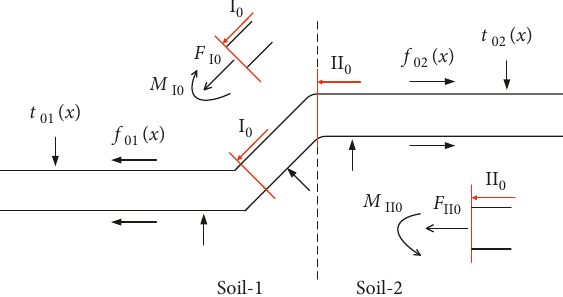
Figure 11: Mechanical model of pipeline caused by uneven settlement.